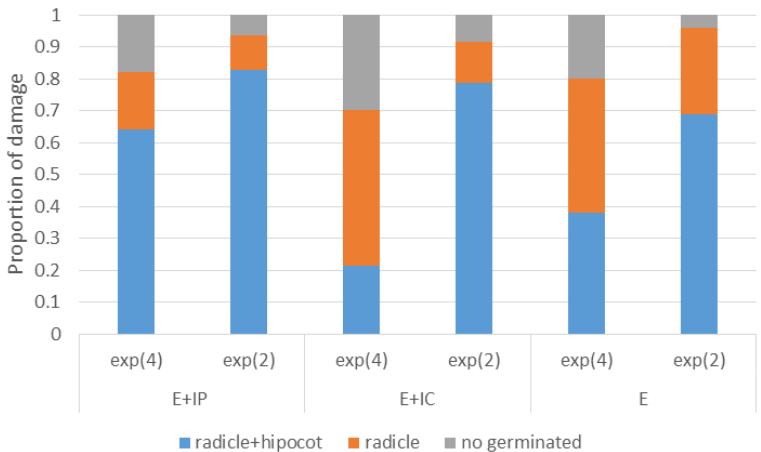
Figure 4. Proportion of P. radiata germlings in each category of growth stage at 48 dpi, with presence of F. circinatum mycelia for each inoculation method and dose applied to surface-disinfested seeds. Exp (4) = 10 4 spores/mL; exp (2) = 10 2 spores/mL; E + IP = internal by immersion of pre-germinated seeds; E + IC = internal by immersion of seeds previously rubbed with carborundum: E = external by immersion.